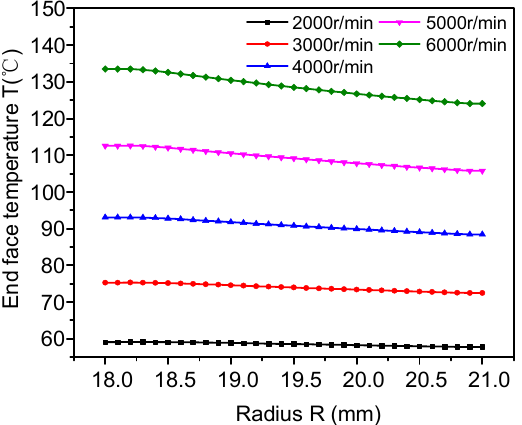
ff erent rotation speeds.